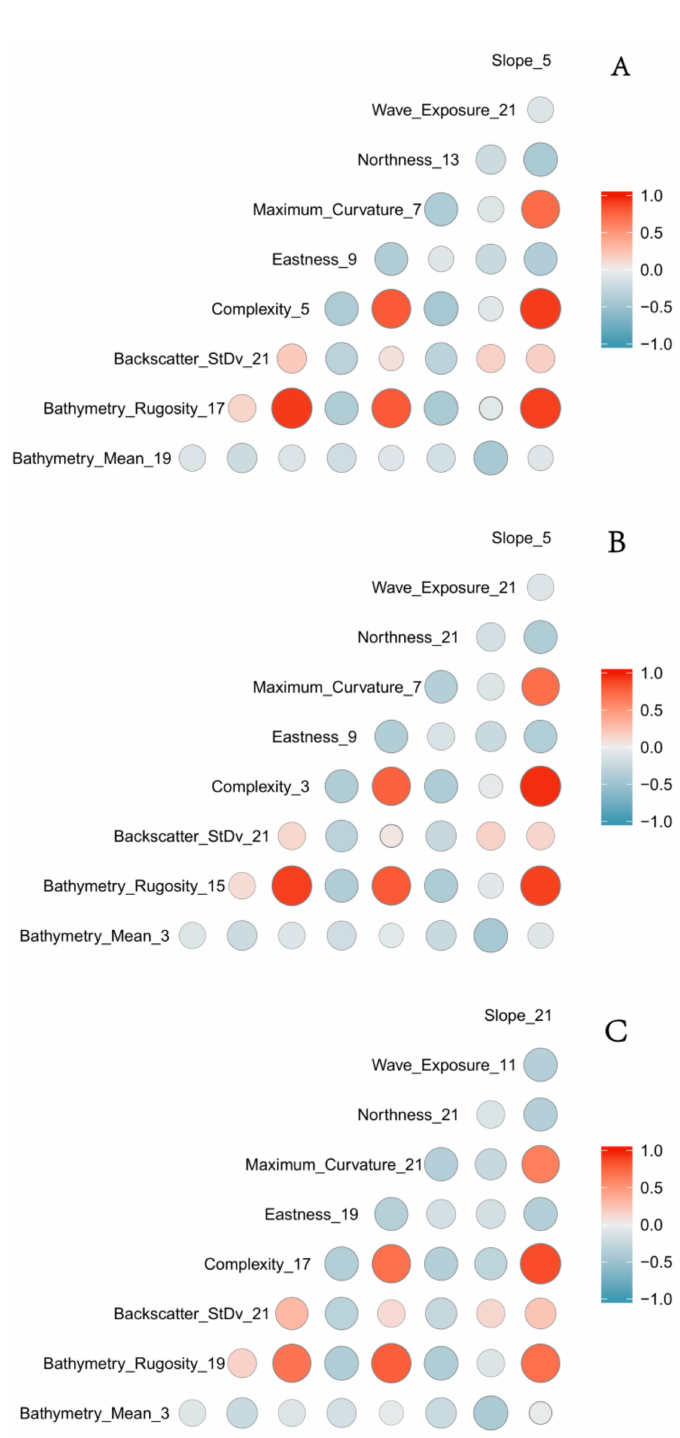
Figure 3. Correlation matrix containing all derivatives used for the three hierarchical models ( A ) BC2, ( B ) BC3, ( C ) BC4. Color and size represent the magnitude and relationship between derivatives. The numbers after the labels represent the scale of analysis (in